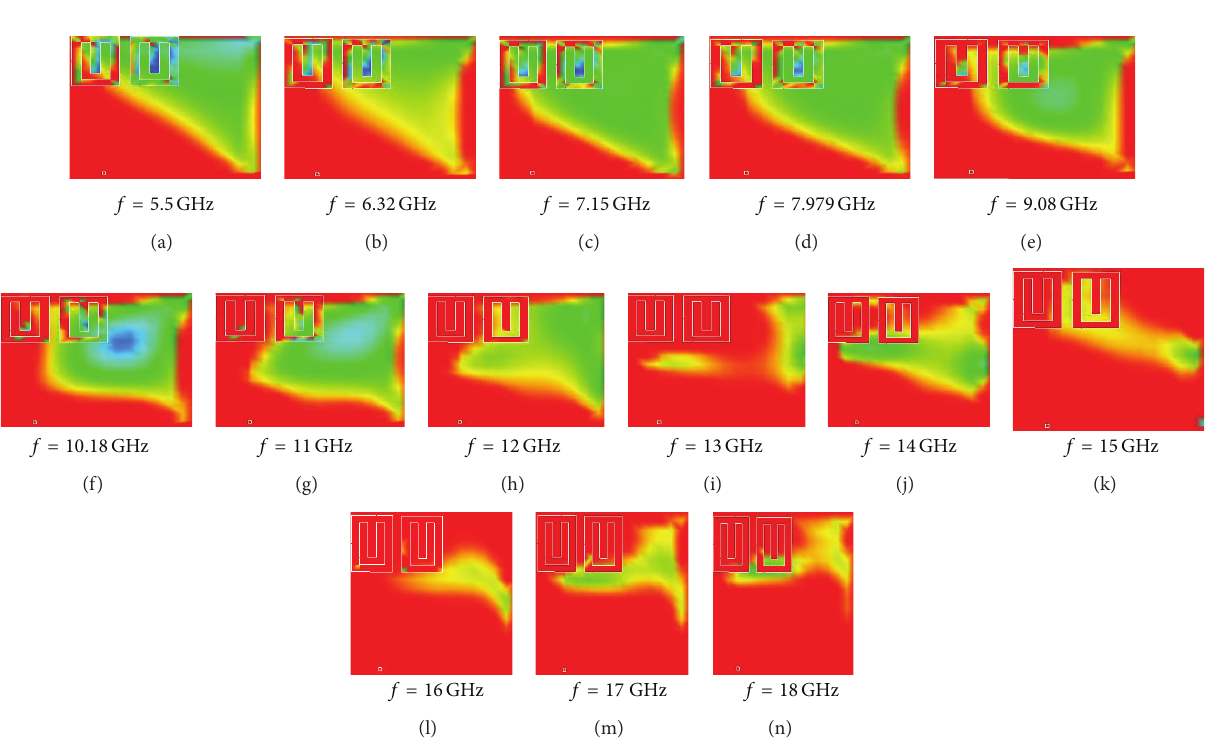
Figure 8: Current density of geometry at different